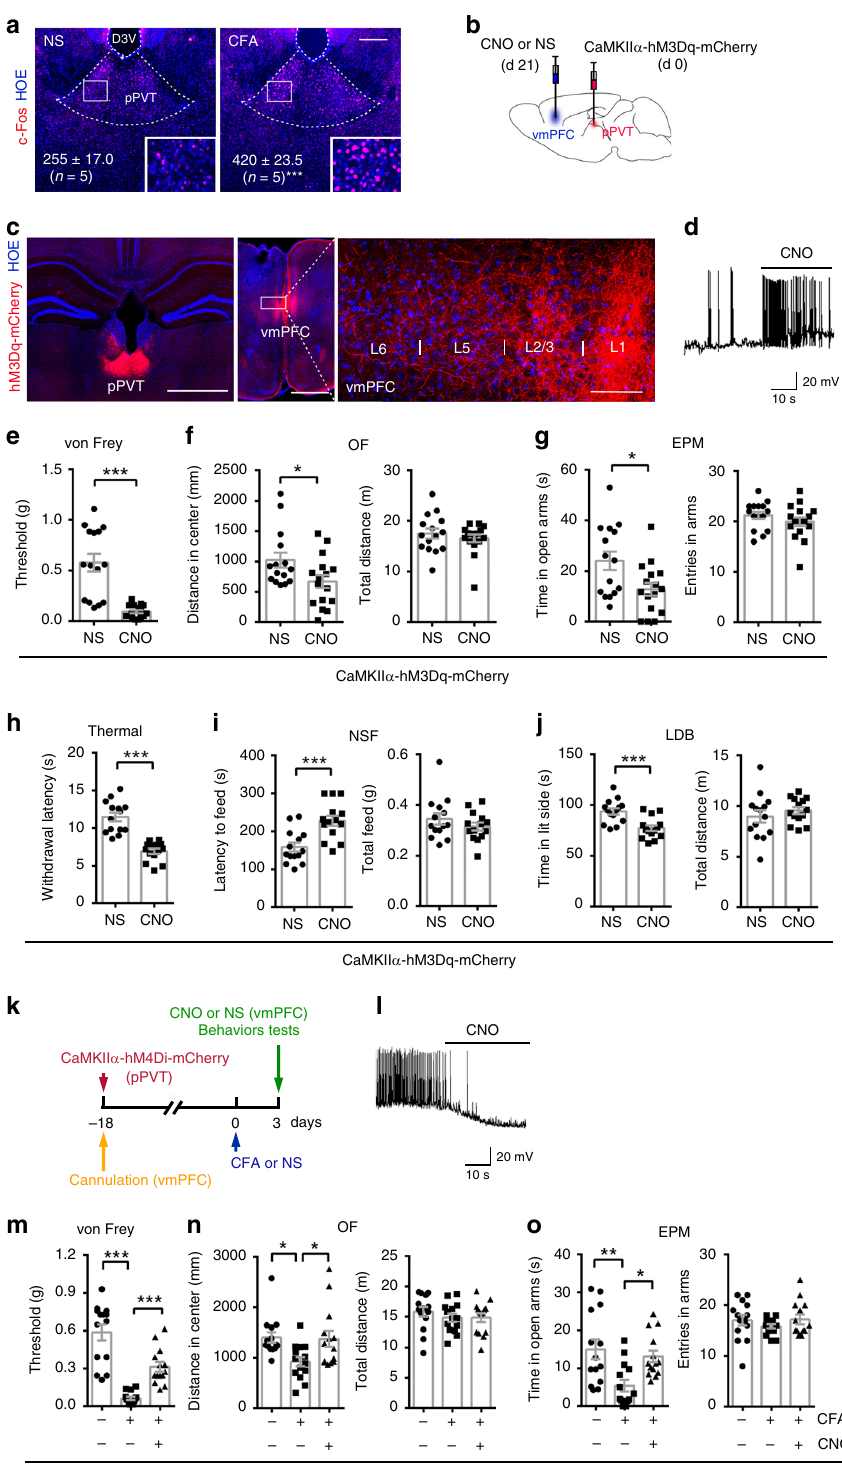
layer 2/3 of the vmPFC after 30 min of bathing with CNO or NS (Fig. 6a). AMPAR-dependent miniature excitatory postsynaptic currents (mEPSCs) were recorded instead of sEPSCs to exclude the in fl uence of network activity, and the AMPA/NMDA ratio was also recorded. The results indicated that chemogenetic inhibition of nNOS-expressing neurons by CNO signi fi cantly suppressed the CFA-induced increase in mEPSC amplitude